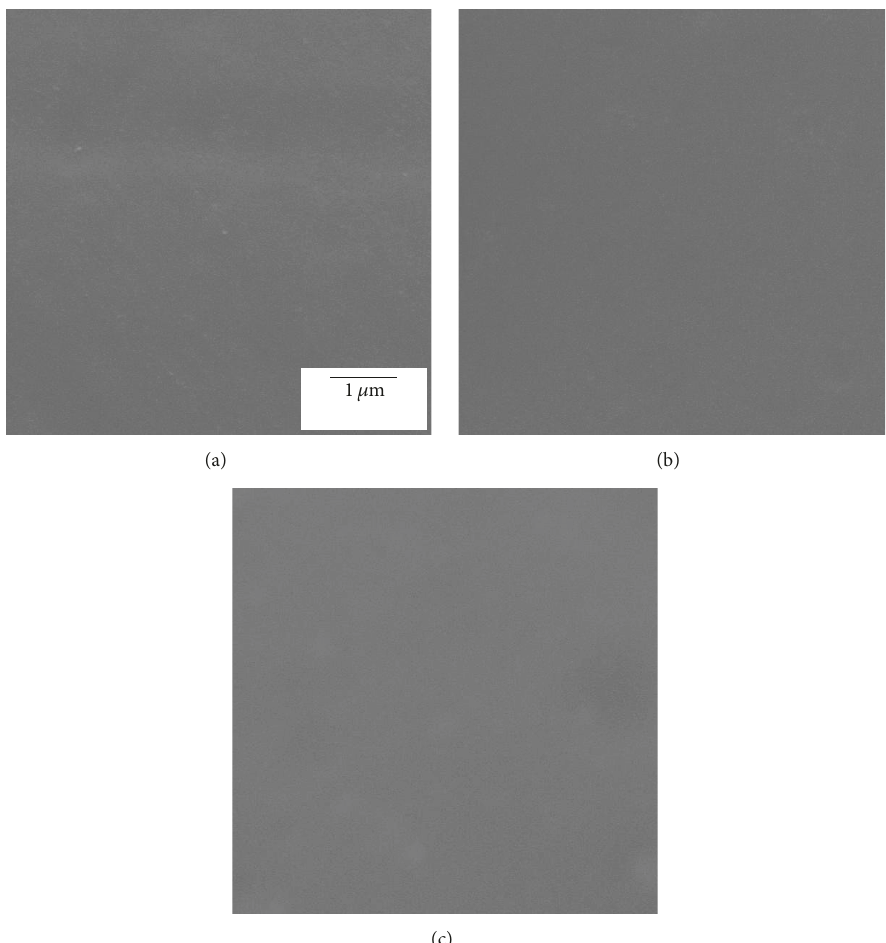
Figure 3: SEM images in surface morphology of PI films before and after surface modification with 1.0g/L TiO 2 dispersed solution for 30 min, UV power: (a) 0W, (b) 100W, and (c) 300 W.